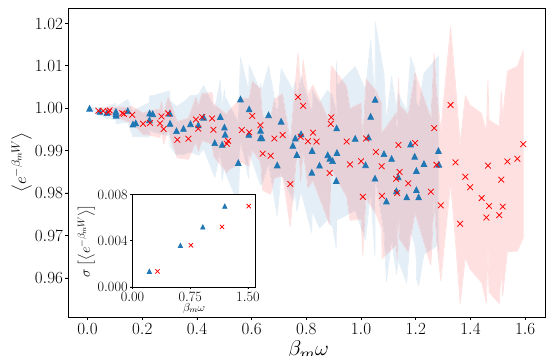
FIG. 3. Average exponentiated work (cid:5) e − β m W (cid:2) for a qubit driven by a Hadamard gate, as measured using the standard TPM (red crosses) and the AATPM (blue triangles), for various values of measured rescaled inverse temperature β m ω . Inset: the rela- tive statistical uncertainty for some values of β m ω obtained as the standard deviations of averages as detailed in the